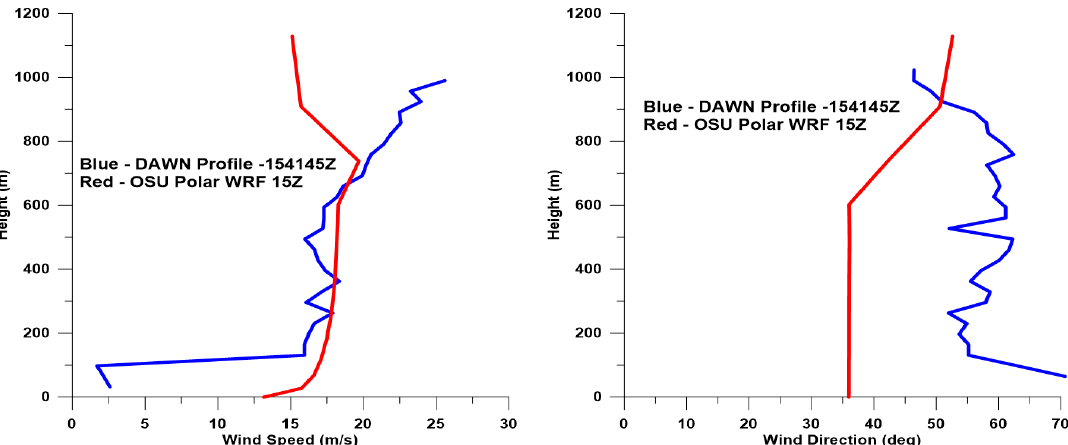
Figure 20. DAWN and model profiles of wind speed ( left ) and wind direction ( right ) near 1542Z on 31 October 2014 for the middle of leg 6 south of the tip.